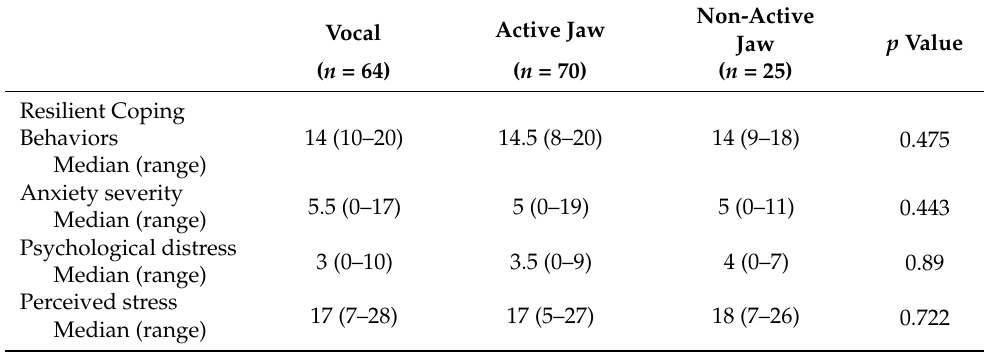
Table 4. Comparison of psychosocial factors and co-variates among musicians.